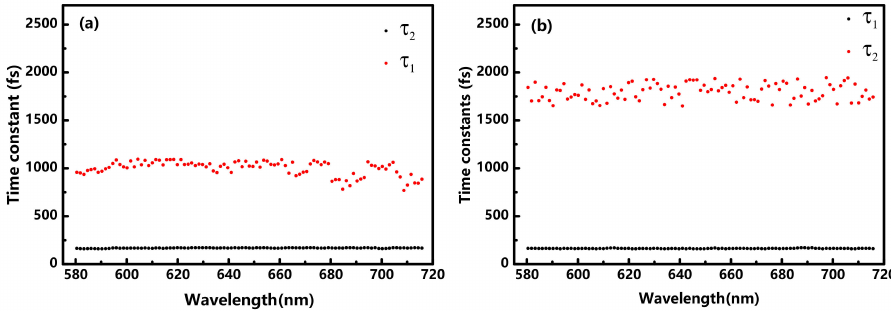
Figure 3. Time constants obtained by a calculation using a two-exponential function for ( a ) P51 without DIO additives; ( b ) P51 with DIO